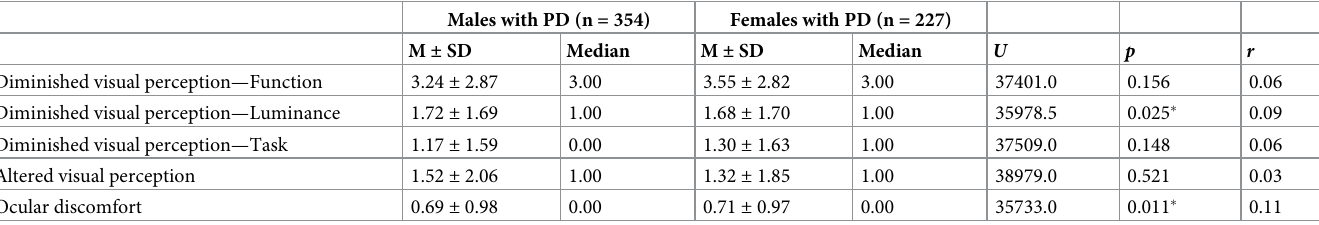
Table 7. Subscale scores of male and female individuals with PD, with Mann-Whitney U test results. Males with PD (n =